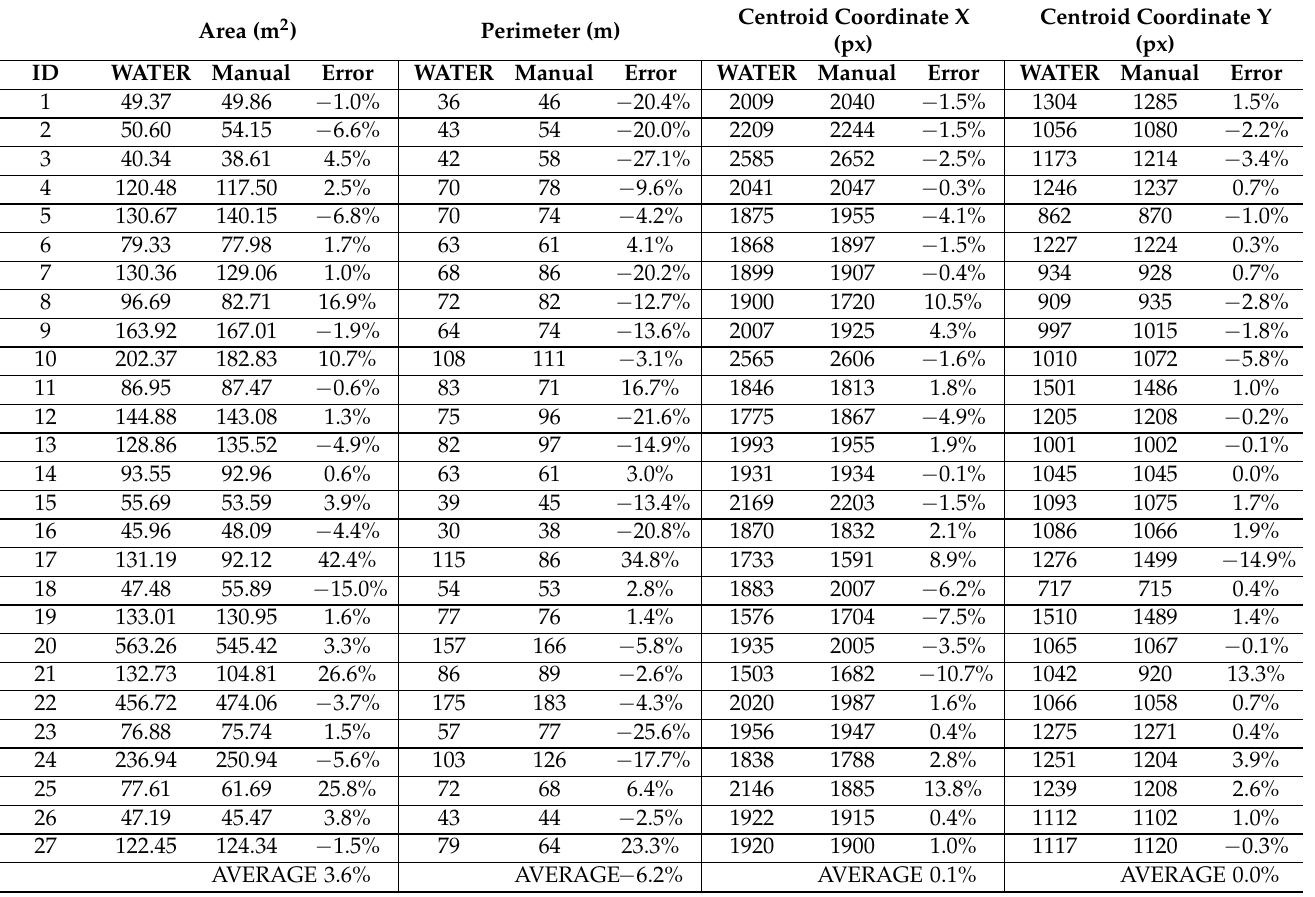
Table 2. Summary of WATER performance as a function of water extent area, water extent perimeter, and centroid coordinates. Errors were computed as ( V WATER − V Manual ) / V Manual , where V WATER is the variable in question retrieved by WATER and V Manual is the variable in question retrieved by manual